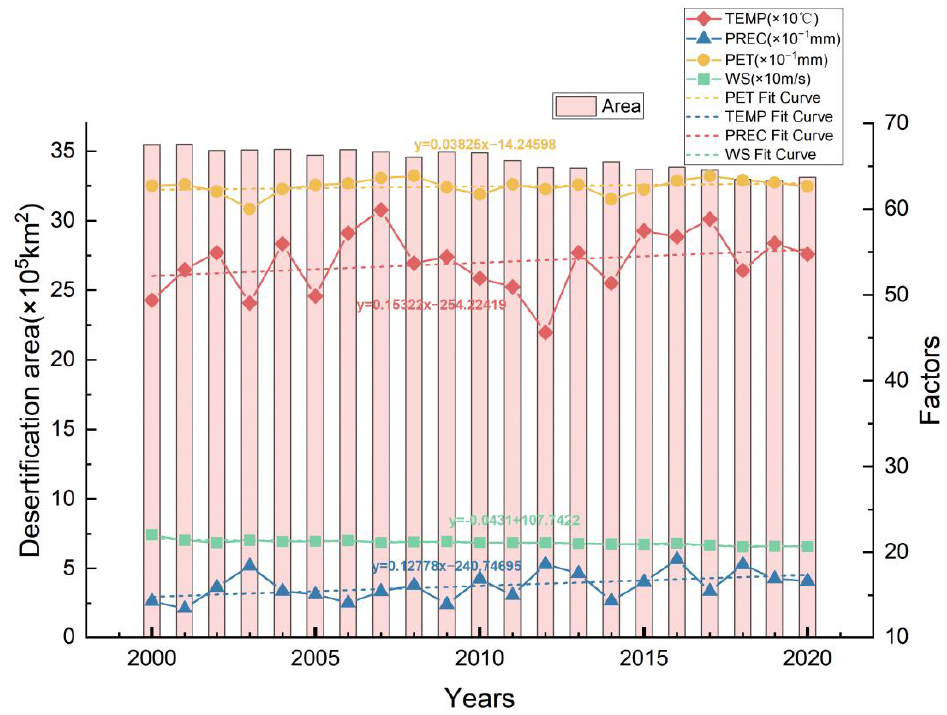
Figure 10. The year-to-year trend of climate factors. Pink bars are areas of relatively increasing desertification area. TEMP, PREC, PET, and WS represent temperature, precipitation, potential evapotranspiration, and wind speed, respectively.